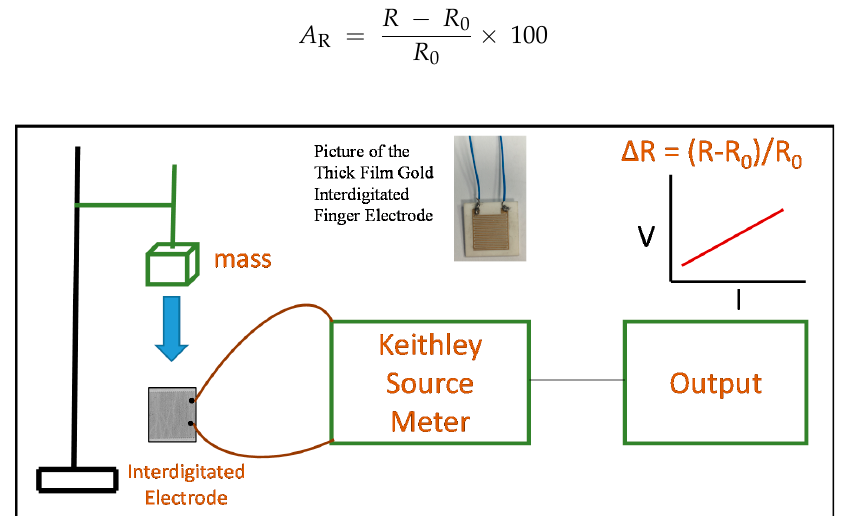
Figure 3. Schematic representation of the experimental setup for the pressure sensing experiment. A picture of the interdigitated electrode used in the measurements is also